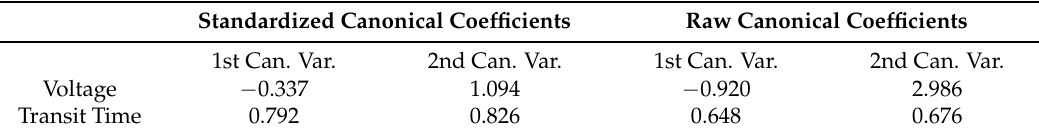
Table 4. Canonical variate coefficients of output